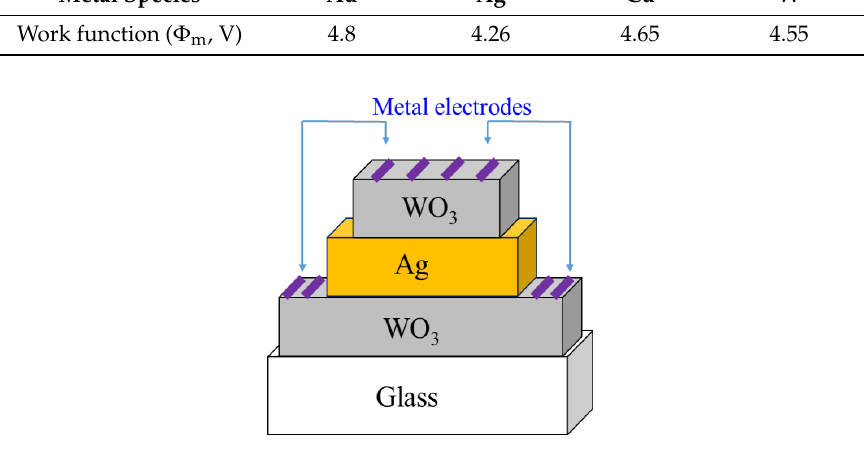
Figure 6. Three-layer transparent conductive film structure of WO 3 /Ag/WO 3 with deposited metal electrodes.